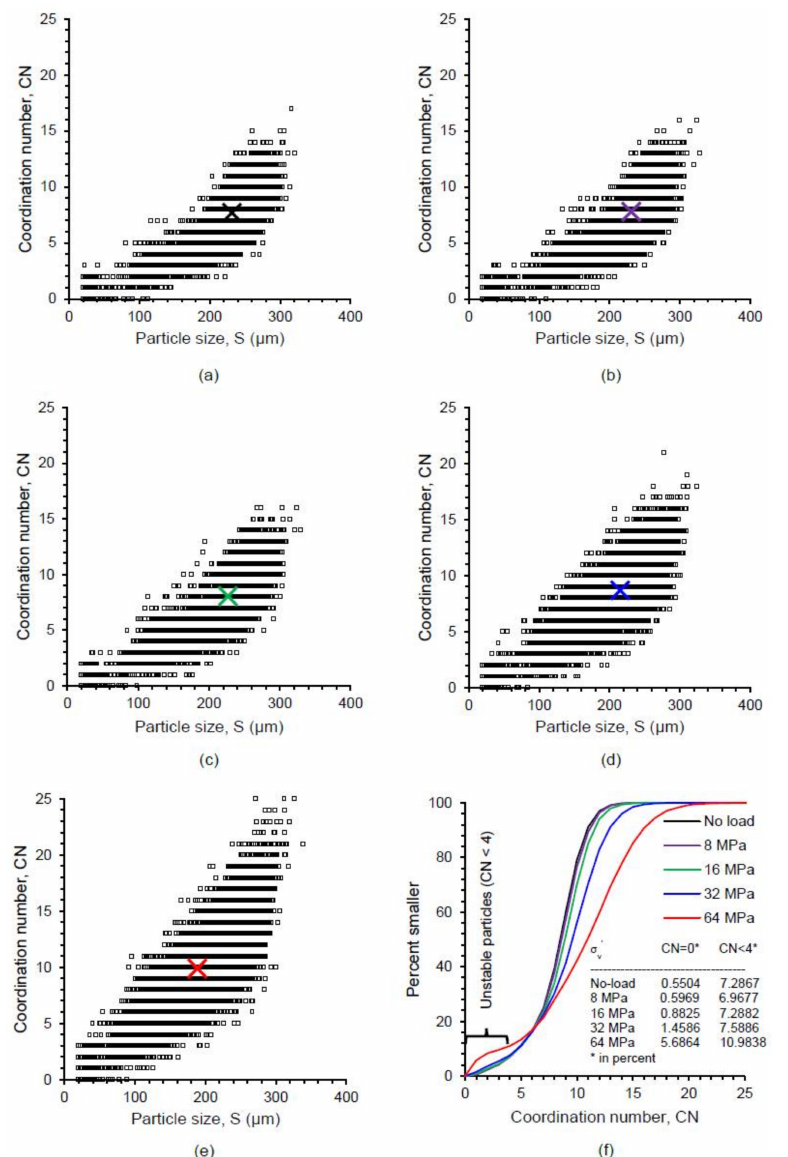
Figure 14. Coordination number of RBS particles at different vertical stresses: ( a ) No-load; ( b ) 8 MPa; ( c ) 16 MPa; ( d ) 32 MPa; ( e ) 64 MPa; ( f ) distributions of coordination number (X marks represent data